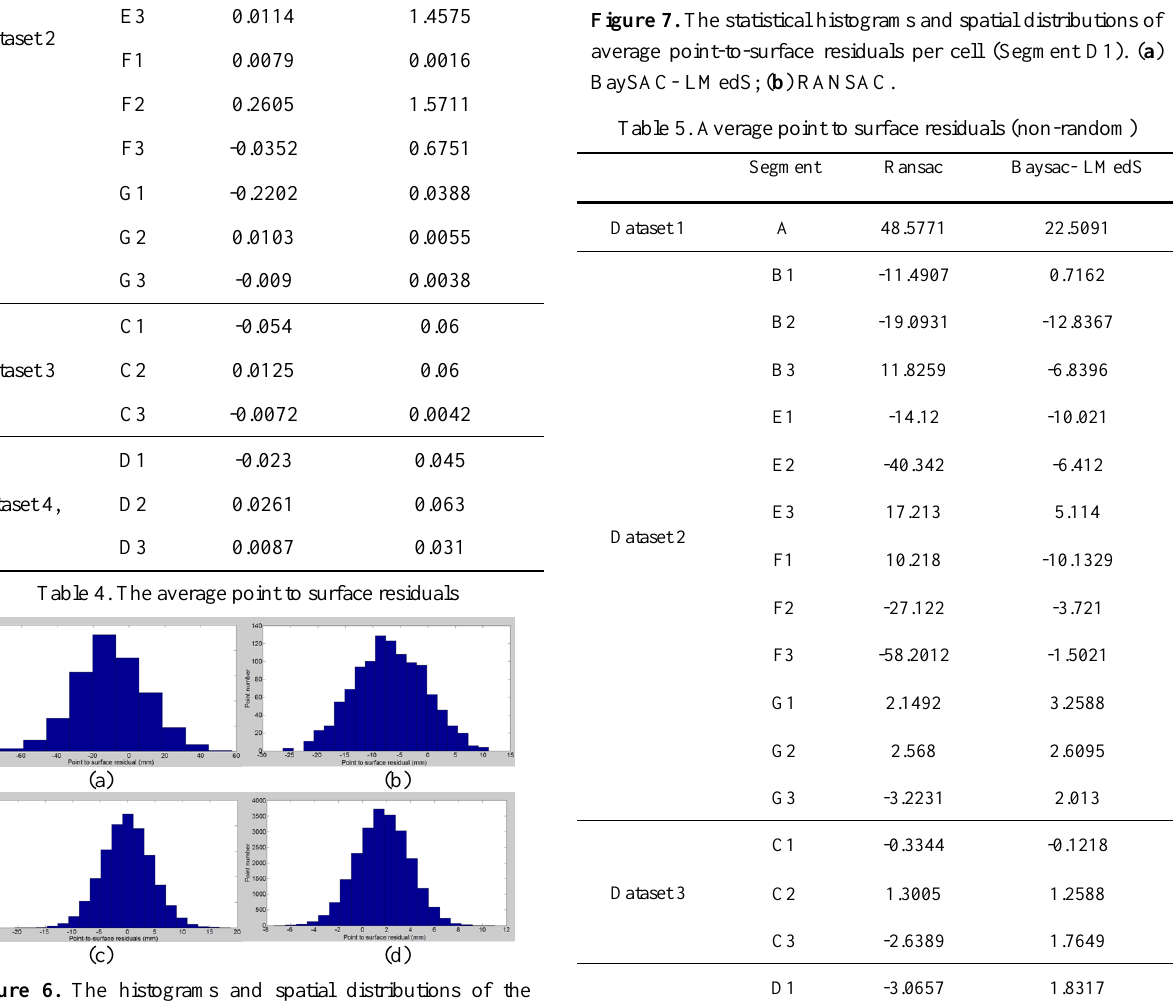
Figure 6. The histograms and spatial distributions of the distance between the transformed points and the surface fitted to the points in the fixed scan. ( a ) Segment A; ( b ) Segment B1; ( c ) Segment C1; ( d ) Segment residual 4.8mm), while the average residual of RANSAC is